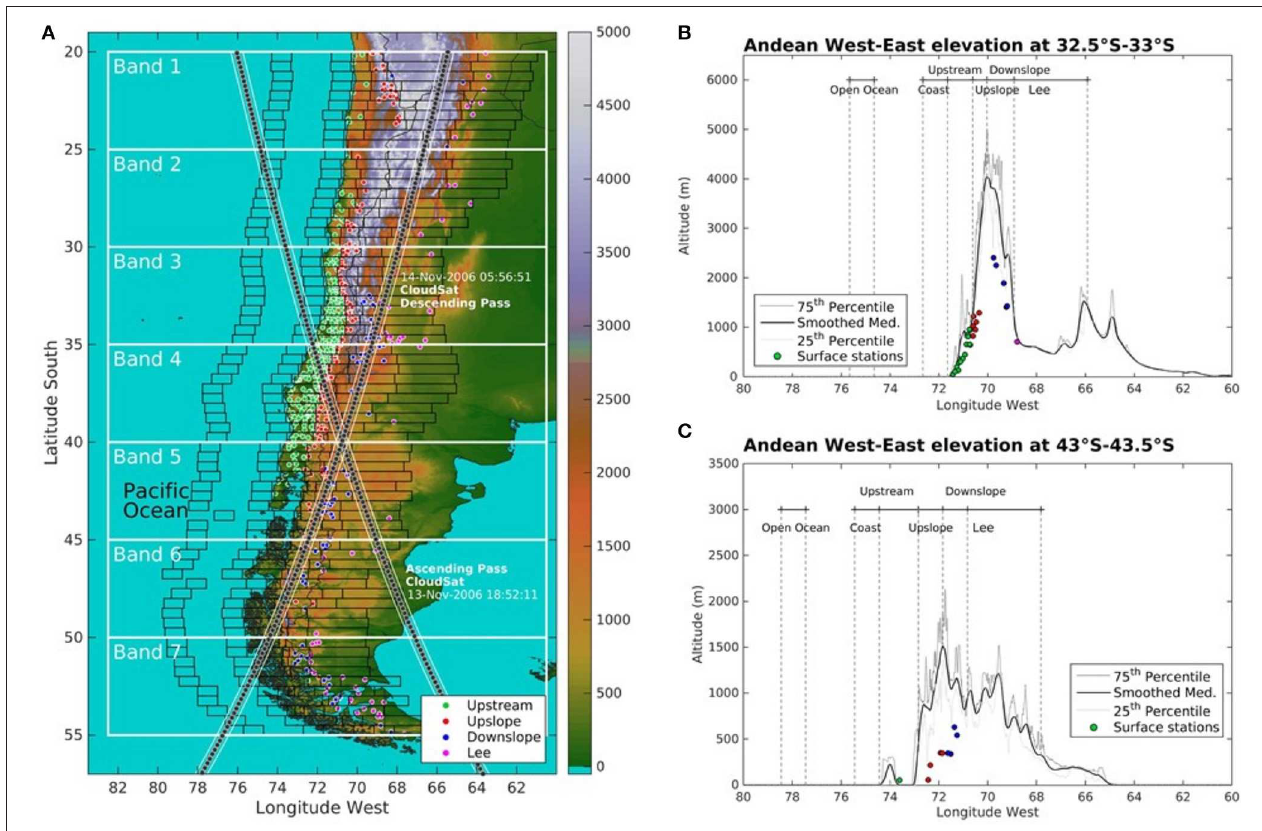
FIGURE 1 | (A) Map showing the study region in southwestern South America with the location of daily surface precipitation sensors represented by circles colored according to its location with respect to the Andes crest. A color-coded topographic map is included with the Argentina-Chile border that represents approximately the crestline of the Andes. Two swaths of the polar-orbiting CloudSat satellite are plotted to illustrate the methodology for grouping the datasets. (B,C) Two meridionally averaged west-east cross sections of the Andes altitude (black line) and its 25th and 75th percentile altitudes (light and dark gray lines) are presented for the 33–33.5 ◦ S and the 43–43.5 ◦ S latitudinal bands, representative of the subtropical and extratropical Andes, respectively. A total of 70 cross sections shown in (A) and calculated within 0.5 ◦ -width rectangles are used to define cross-barrier zones for grouping meridionally the surface and satellite data. The white rectangles represent the 5 ◦ -width latitudinal bands used for grouping latitudinally vertical profiles from the CloudSat dataset (see details in the text). Surface precipitation gauges are plotted with green, red, blue, and magenta circles that represent its location in upstream, upslope, downslope, and lee cross-barrier zones,